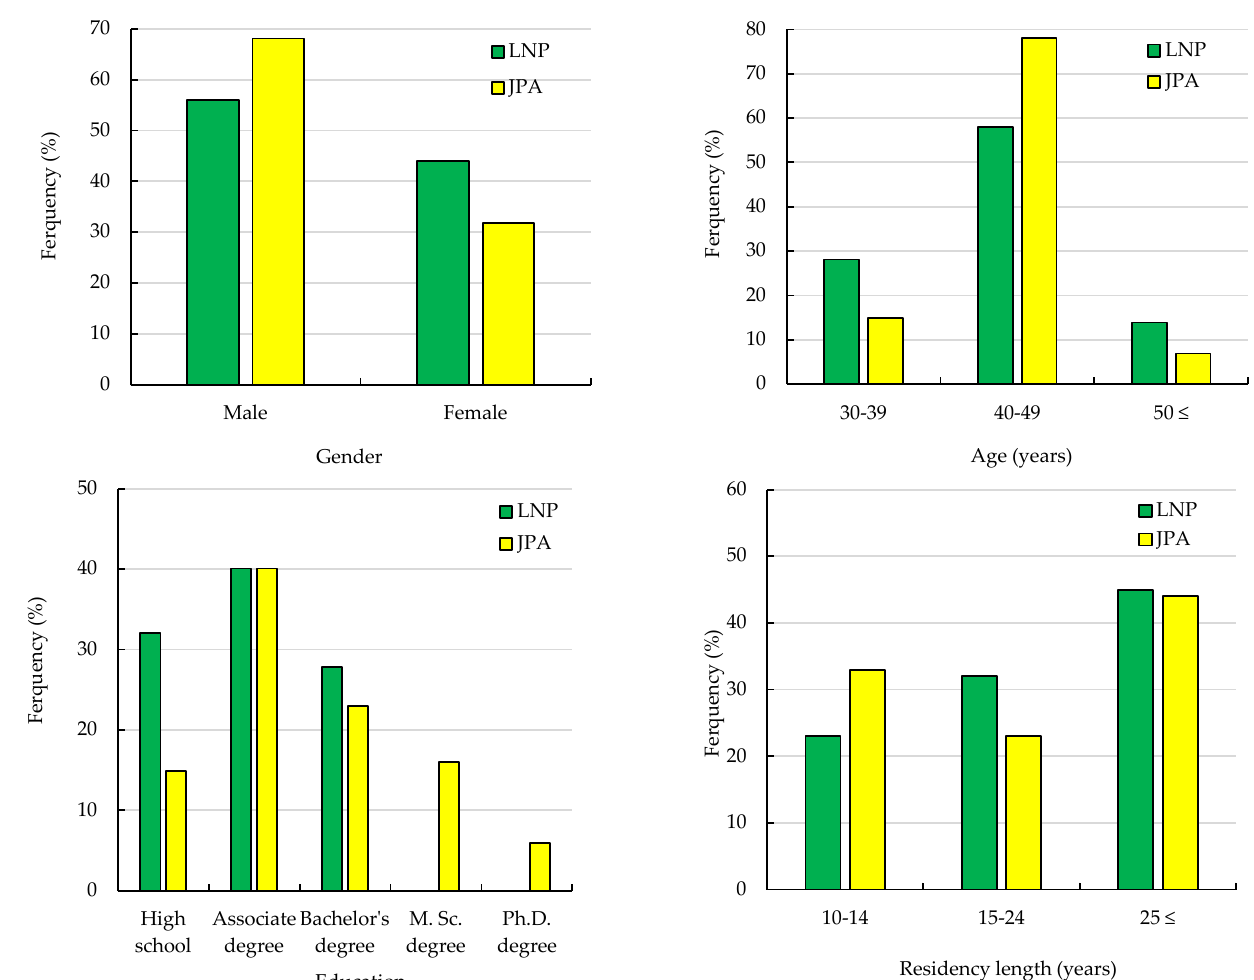
Figure 1. Descriptive profile of survey respondents in two studied areas. Table 1. Evaluation of the (mean) sustainability level of ecotourism development in two protected areas (based on respondents’